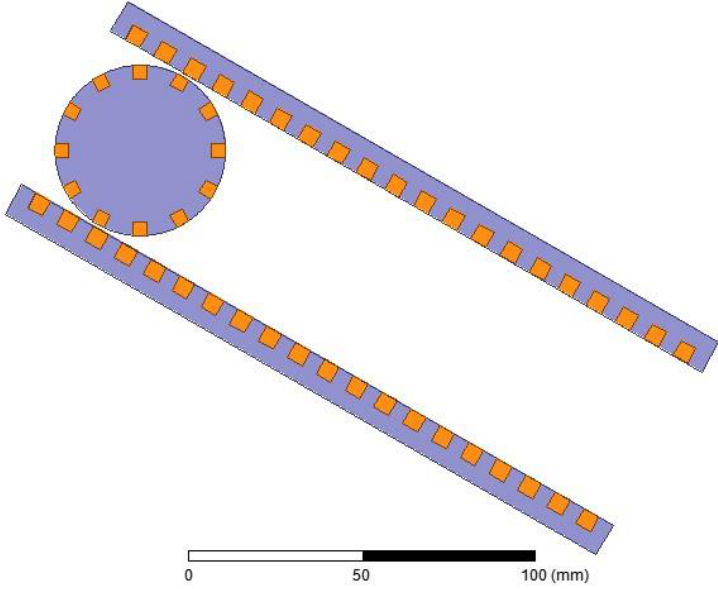
Figure 10. Prepared geometry for finite element analysis (FEA).